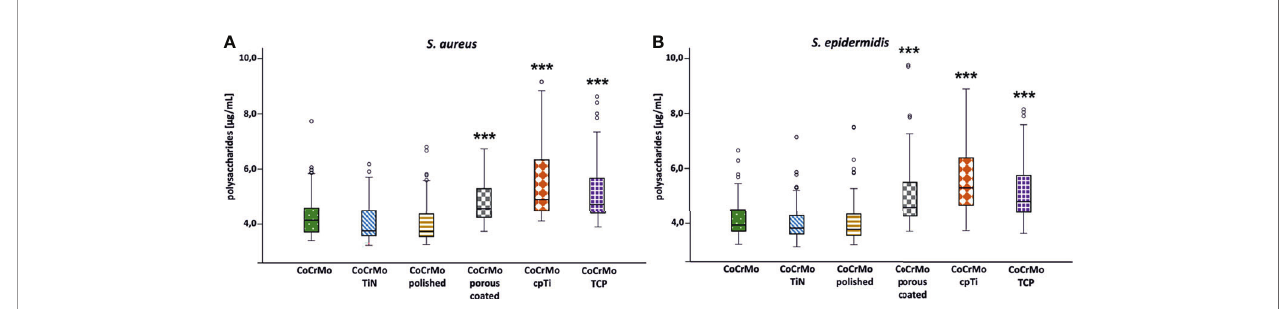
FIGURE 4 | Polysaccharide concentration of S. aureus ( A ; n = 42) and S. epidermidis ( B ; n = 44) bio fi lms. Statistically signi fi cant differences to CoCrMo are marked *** (adjusted signi fi cance < 0.001, Bonferroni correction for the Kruskal – Wallis test).